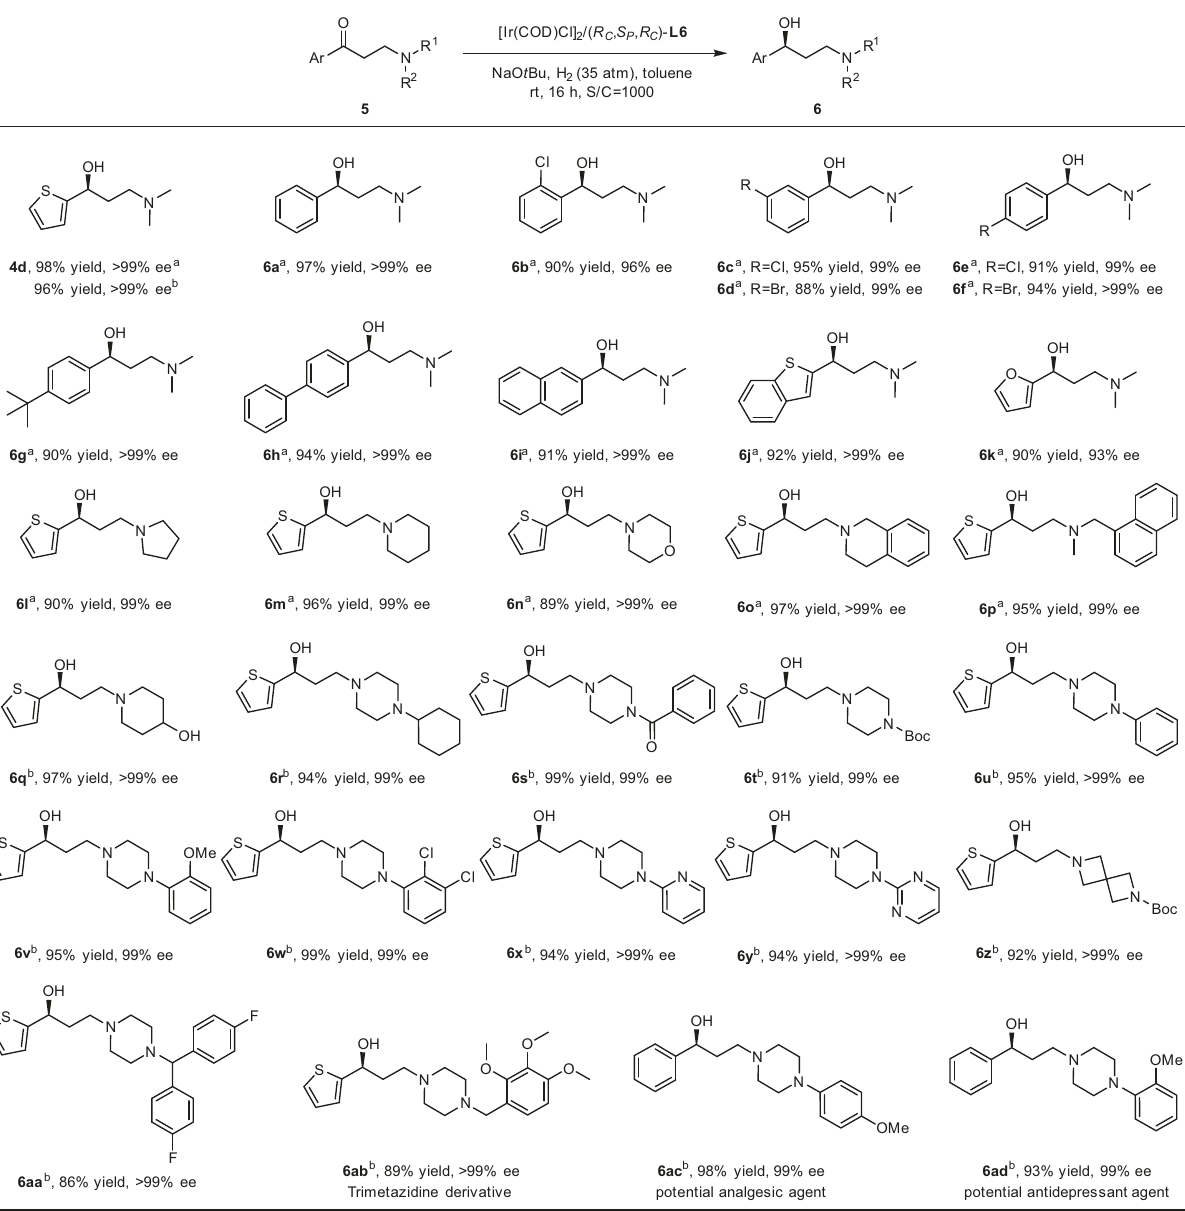
Fig. 4 Asymmetric hydrogenation of various β -tertiary-amino ketones with Ir-(RC,SP,RC)-L6 catalyst. a Condition A: 0.4 mmol 5 ·HCl, 0.05 mol% [Ir(COD)Cl] 2 , 0.105 mol% ( R C , S P , R C )- L6 , 0.44 mmol NaO t Bu, 3.0 mL toluene, room temperature (25 – 30 °C). b Condition B: 0.4 mmol 5 , 0.05 mol% [Ir(COD)Cl] 2 , 0.105 mol% ( R C , S P , R C )- L6 , 5 mol% NaO t Bu, 3.0 mL toluene, room temperature (25 – 30 °C). Isolated yields. The ee determined by